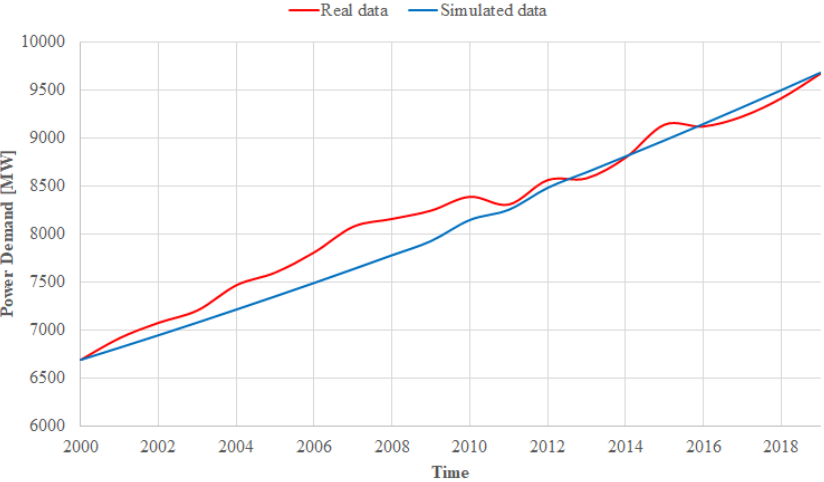
Figure 9. Power demand. The red signal represents the real behavior of the Colombian power demand, obtained with data from [44]. The blue signal was computed with our SD/DS model. MAPE =